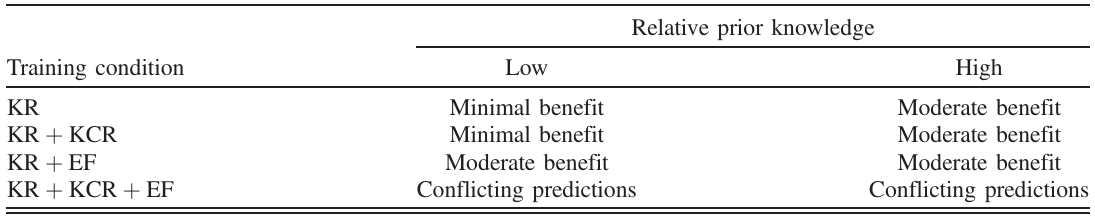
TABLE I. Hypothesized relative benefit from the four training conditions according to prior knowledge level. Relative prior